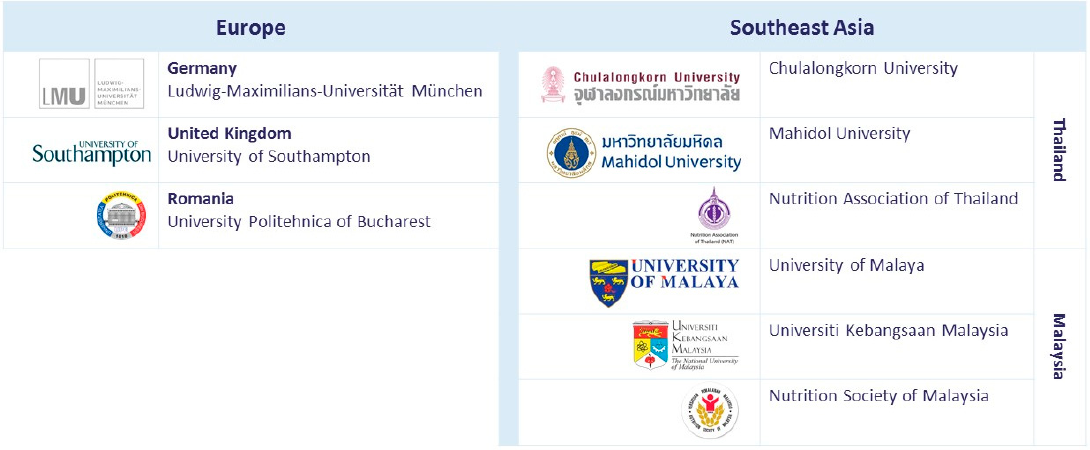
Figure 1. Early Nutrition eAcademy Southeast Asia (ENeA SEA) consortium partners.